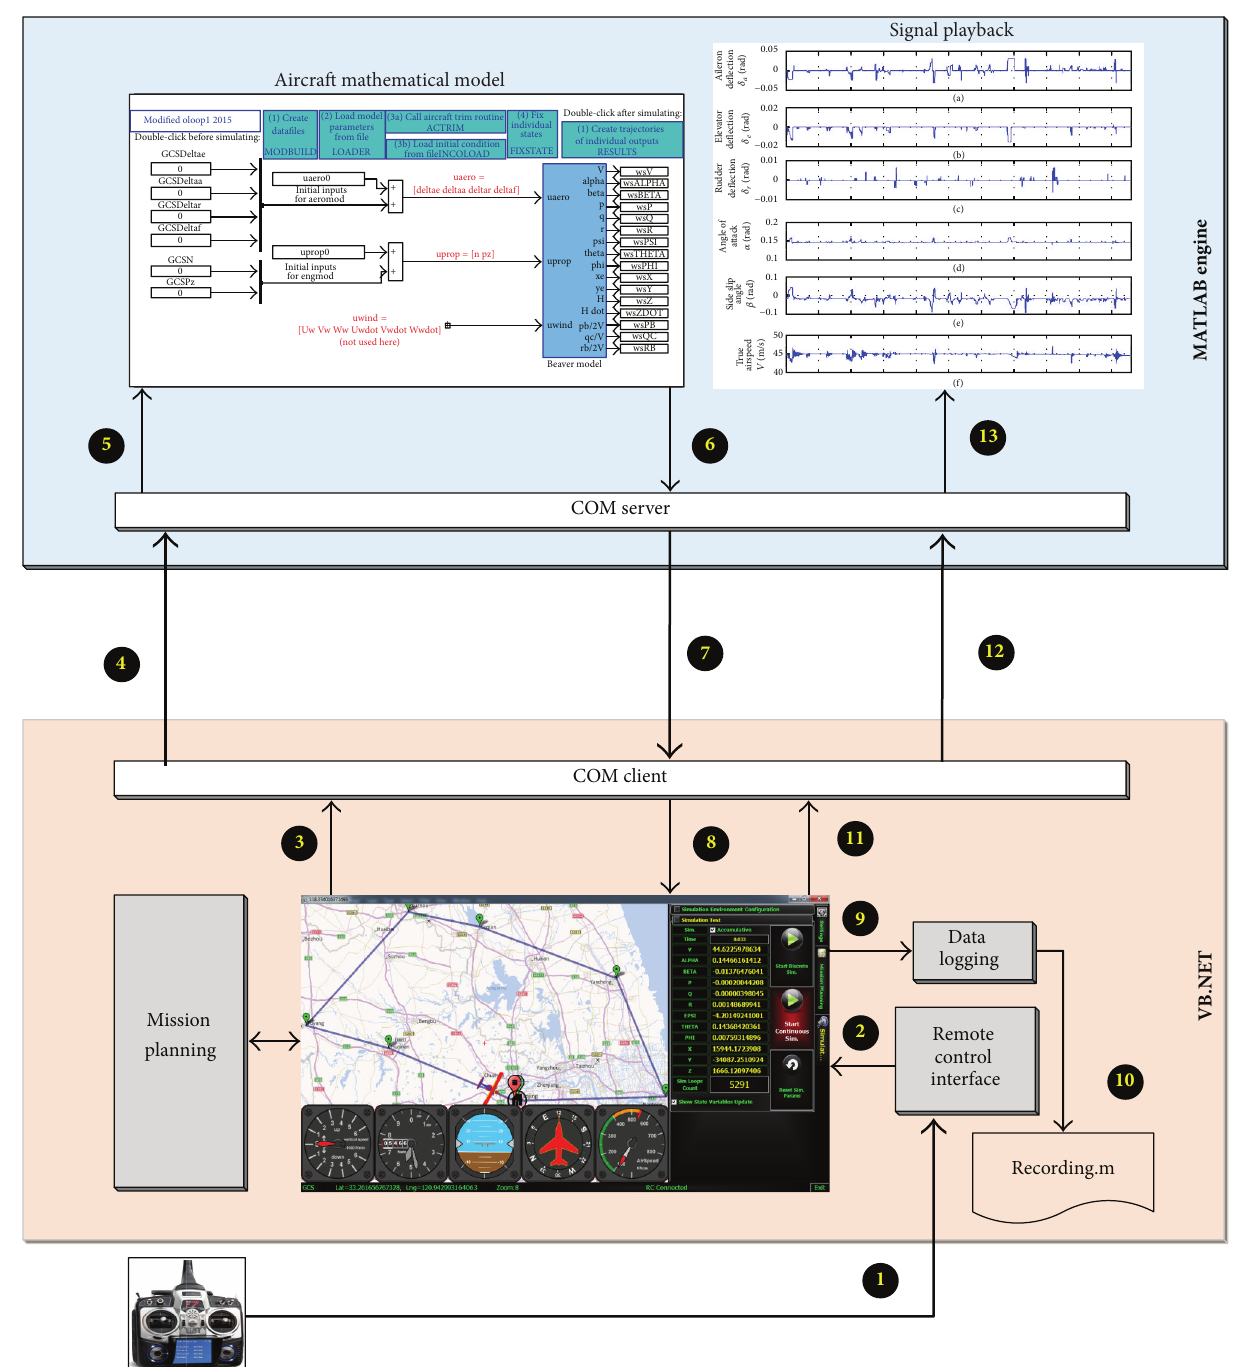
Figure 7: Active hybrid architecture sequence